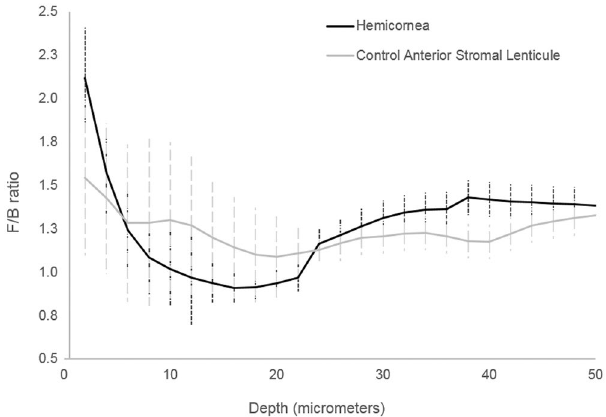
Figure 6. F/B ratio of the hemicornea and control anterior stromal lenticule. Averaged measured forward/ backward SHG intensities as a function of depth (from the Bowman’s layer to 50 µ m depth) for the hemicornea (black curve) and control anterior stromal lenticules (grey curve). The vertical lines represent ± SD.